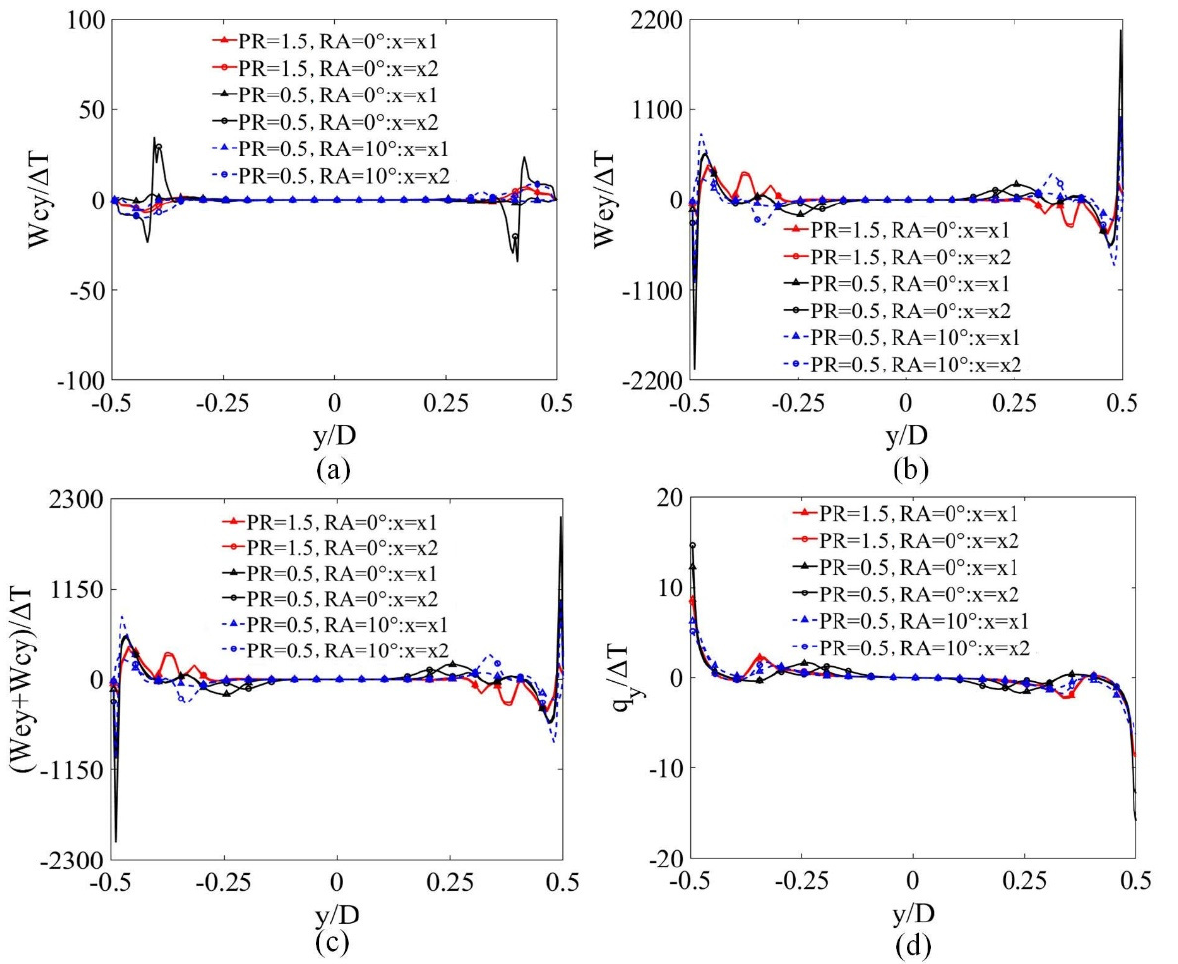
Figure 8. The distributions of ( a ) W cy / ∆ T , ( b ) W ey / ∆ T , ( c ) ( W cy + W ey ) / ∆ T , ( d ) q y / ∆ T on the lines inspected.